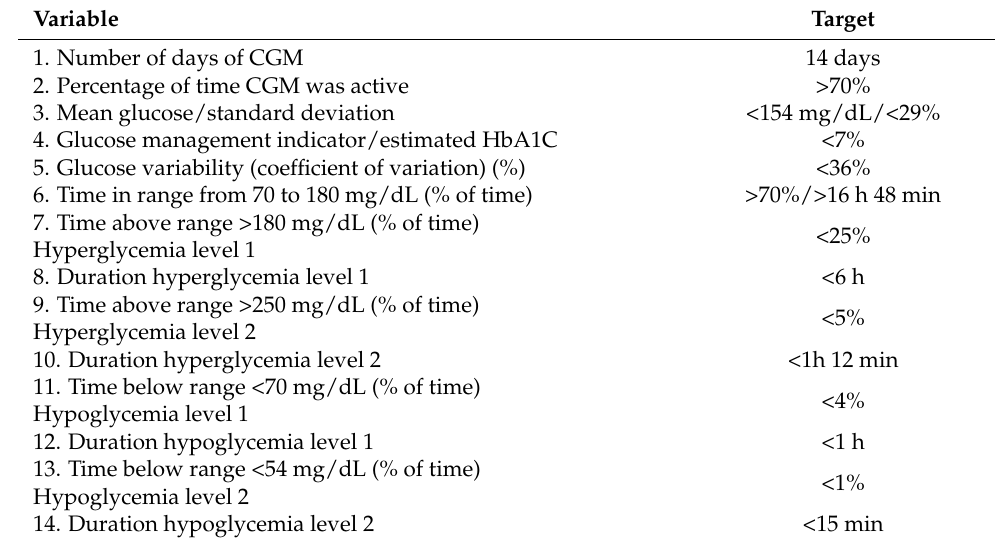
Table 2. Standardized CGM parameters in the ATTD 2019 consensus and target values for